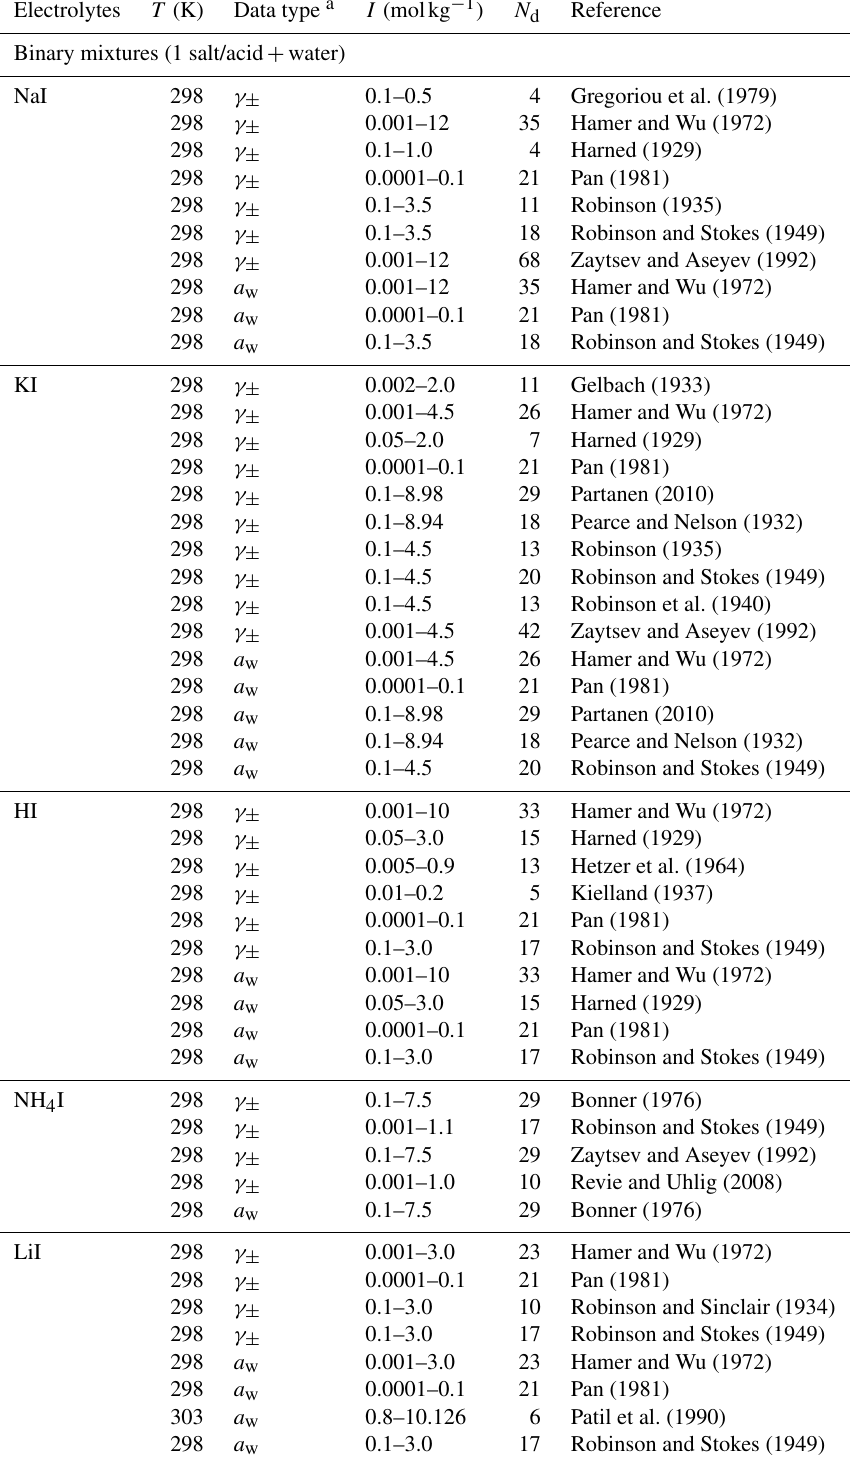
Table 2. Experiment temperature ( T ), data type, molal ionic strength ( I ) range, number of points ( N d ), and references for data used to fit the MR interaction parameters of cation–anion pairs in aqueous iodide or iodate